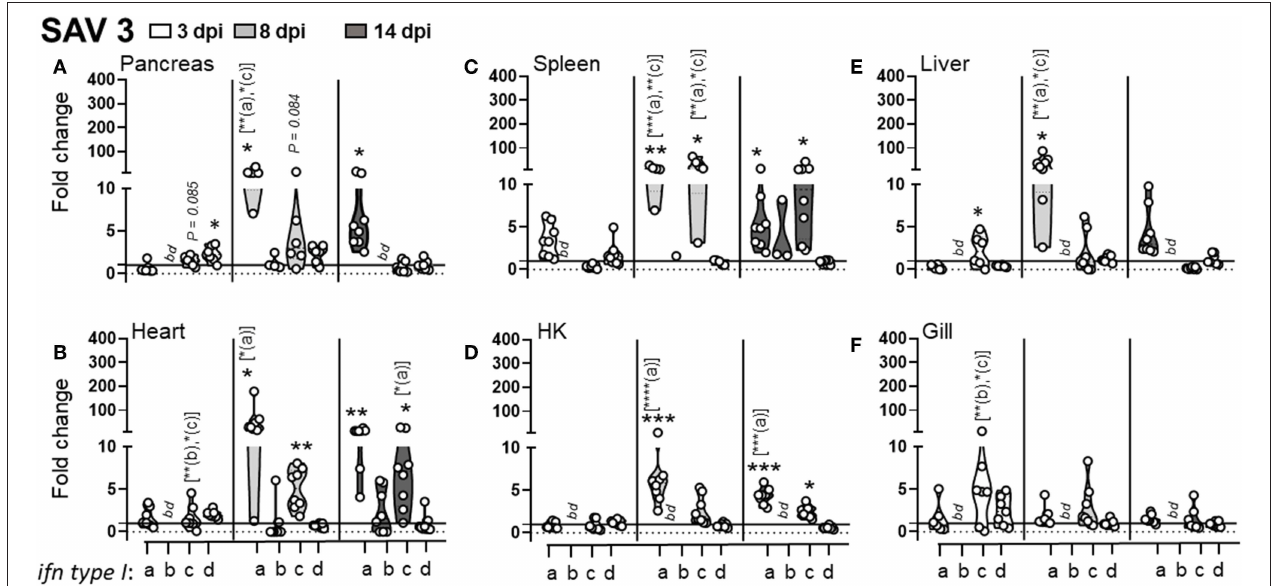
FIGURE 5 | SAV3 infection elicit predominant type I IFNa and IFNc responses. Pre-smolt Atlantic salmon were intra peritoneal (i.p) injected with 100 µ l SAV3 (1 × 10 5 TCID 50 ) or PBS and samples were collected at 3, 8, and 14 days post infection. Fold change of type I IFNa; IFNb: IFNc and IFNd in different tissues; (A) pancreas, (B) heart, (C) spleen, (D) head-kidney (HK), (E) liver, and (F) gill at different times post challenge [ n ǫ (7;8)] relative to the control groups from the same time point ( n ǫ 4) is shown. Each dot represents an individual fish and the line intersecting the y-axis at 1 represents the unstimulated control that the fold change of the treatments is in relation to. Asterisks above each violin plot indicates the strength of significance compared to PBS injected controls, and letters above each violin represent statistical differences among the different time points for each individual gene ( a = 3 dpi; b = 8 dpi; and c = 14 dpi), bd , below detection, * p < 0.05, ** p < 0.01, *** p = 0.0001, **** p < 0.0001. Primer sequences that are conserved for IFNa1 and IFNa2, for all IFNb and all IFNc subtypes were used ( 19).